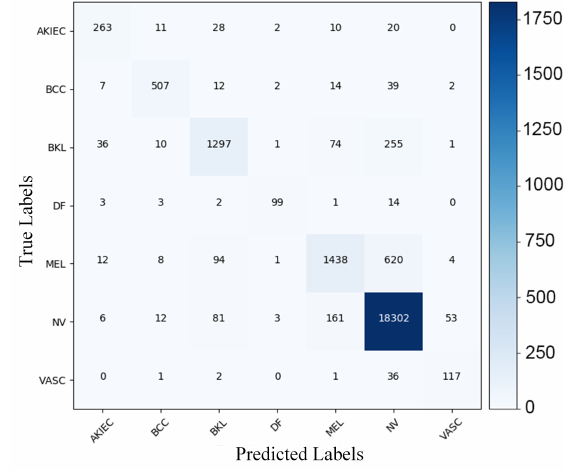
Figure 2. Confusion Matrix showing number of correctly classified and misclassified images per class in ISIC Archive-2018.